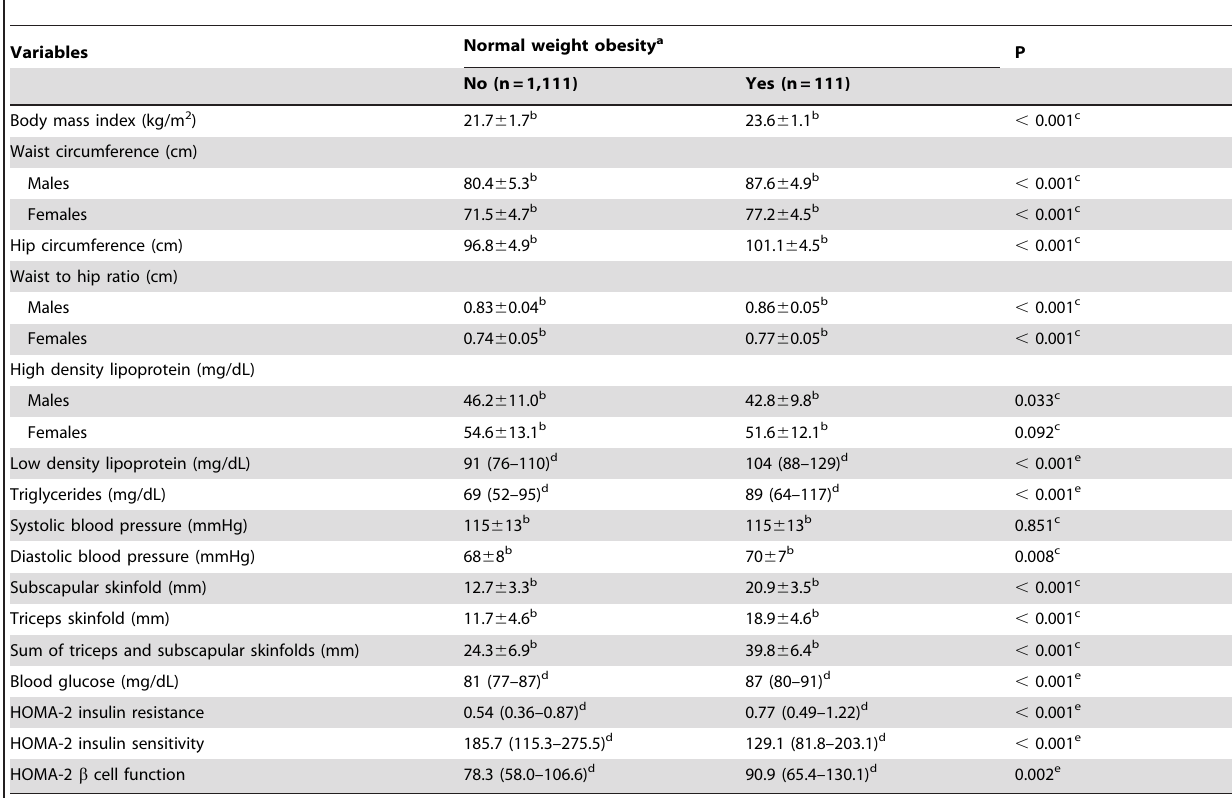
Table 4. Normal weight obesity according to anthropometric and metabolic parameters, 1978/79 Ribeira˜o Preto birth cohort.